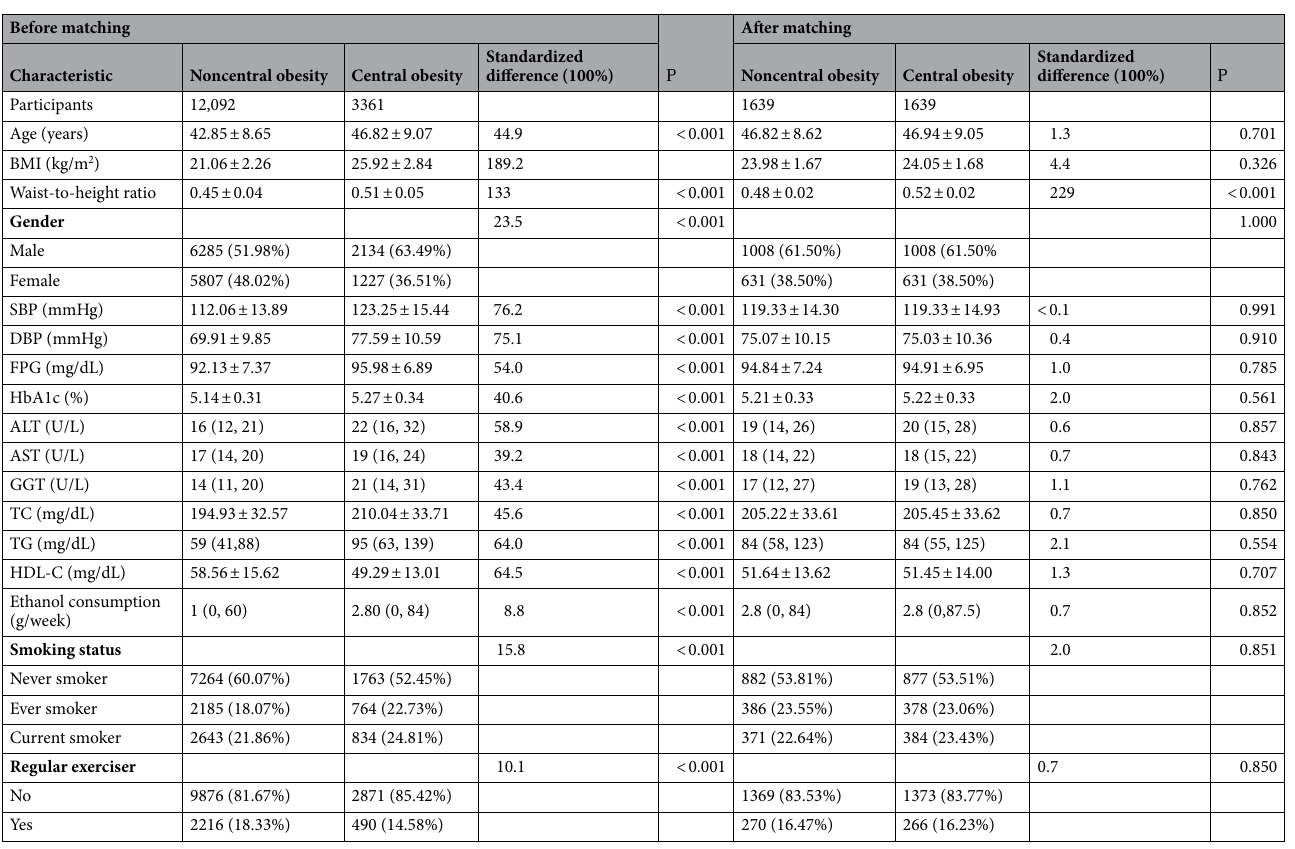
Table 1. Baseline characteristics before and after propensity score matching. Values were n (%) or mean ± SD or median (interquartile range: 25th to 75th percentiles). SD standard deviation, BMI body mass